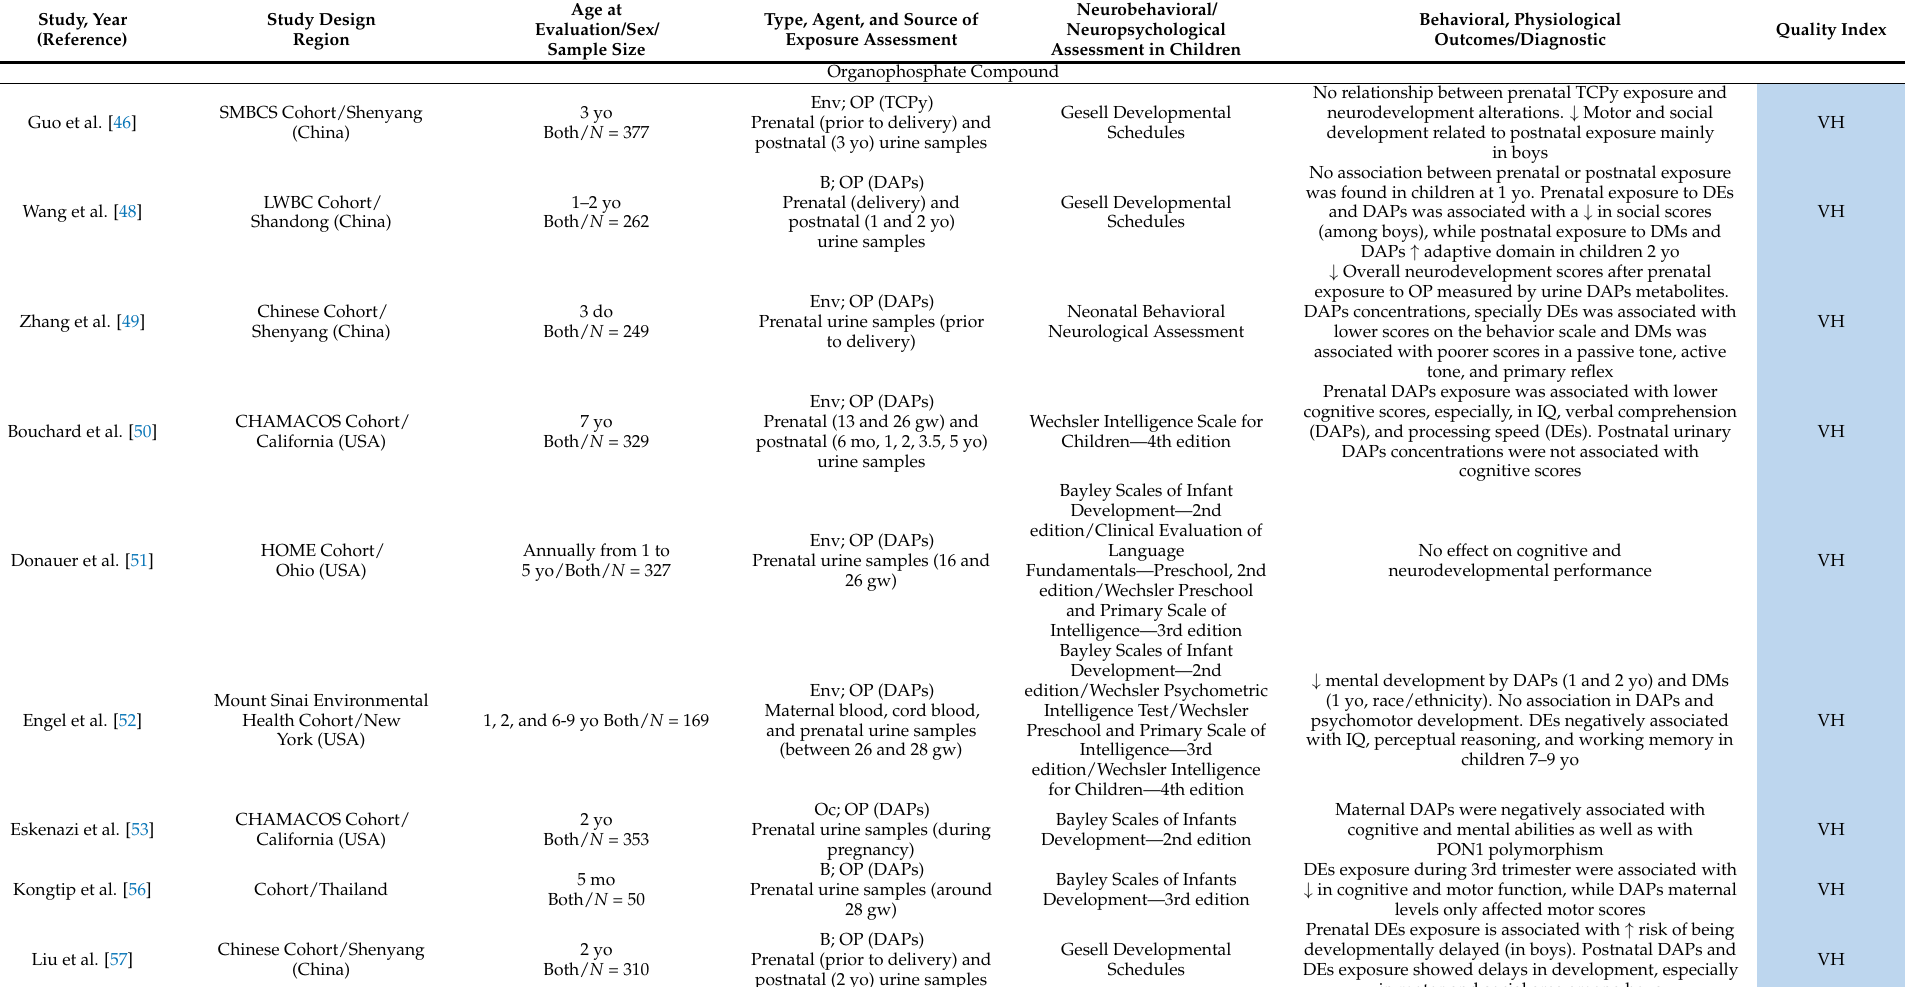
Table 2. ASD & clinical studies. From the left to the right: Study ID, Study design/region, age at evaluation/sex/sample size, type, agent and source of exposure assessment, neurobehavioral or neuropsychological assessment in children, behavioral/physiological outcomes or Diagnostic and quality of the study. Study, Year